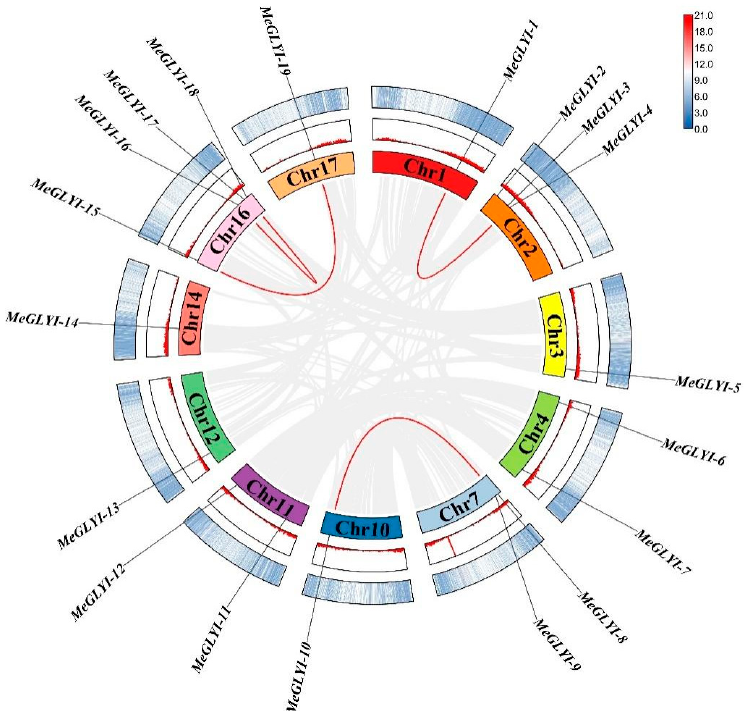
Figure 1. Distribution and collinearity analysis of the glyoxalase I gene family on chromosomes. Chr, chromosome; the gray line represents all of the collinear relationships in the cassava genome, while the red line represents the pairwise replication of the MeGLYI gene family.